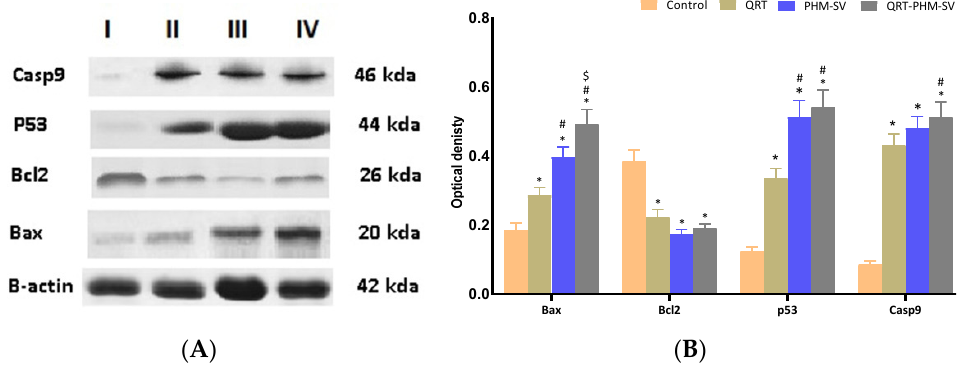
Figure 11. Western blots ( A ); histogram of proteins expression of Bax, Bcl2, P53 and Casp9 ( B ) for the four groups in MCF-7 cells; ( I ) untreated control; ( II ) QRT; ( III ) PHM-SV; ( IV ) QRT-PHM-SV. * Significantly different from control at p < 0.05; # significantly different from QRT at p < 0.05; $ Significantly different from PHM-SV at p < 0.05.